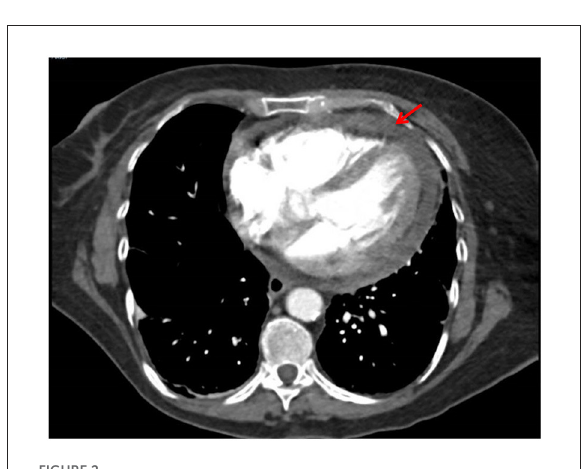
FIGURE2 Pericardial effusion after 6 cycles of pembrolizumab (Case